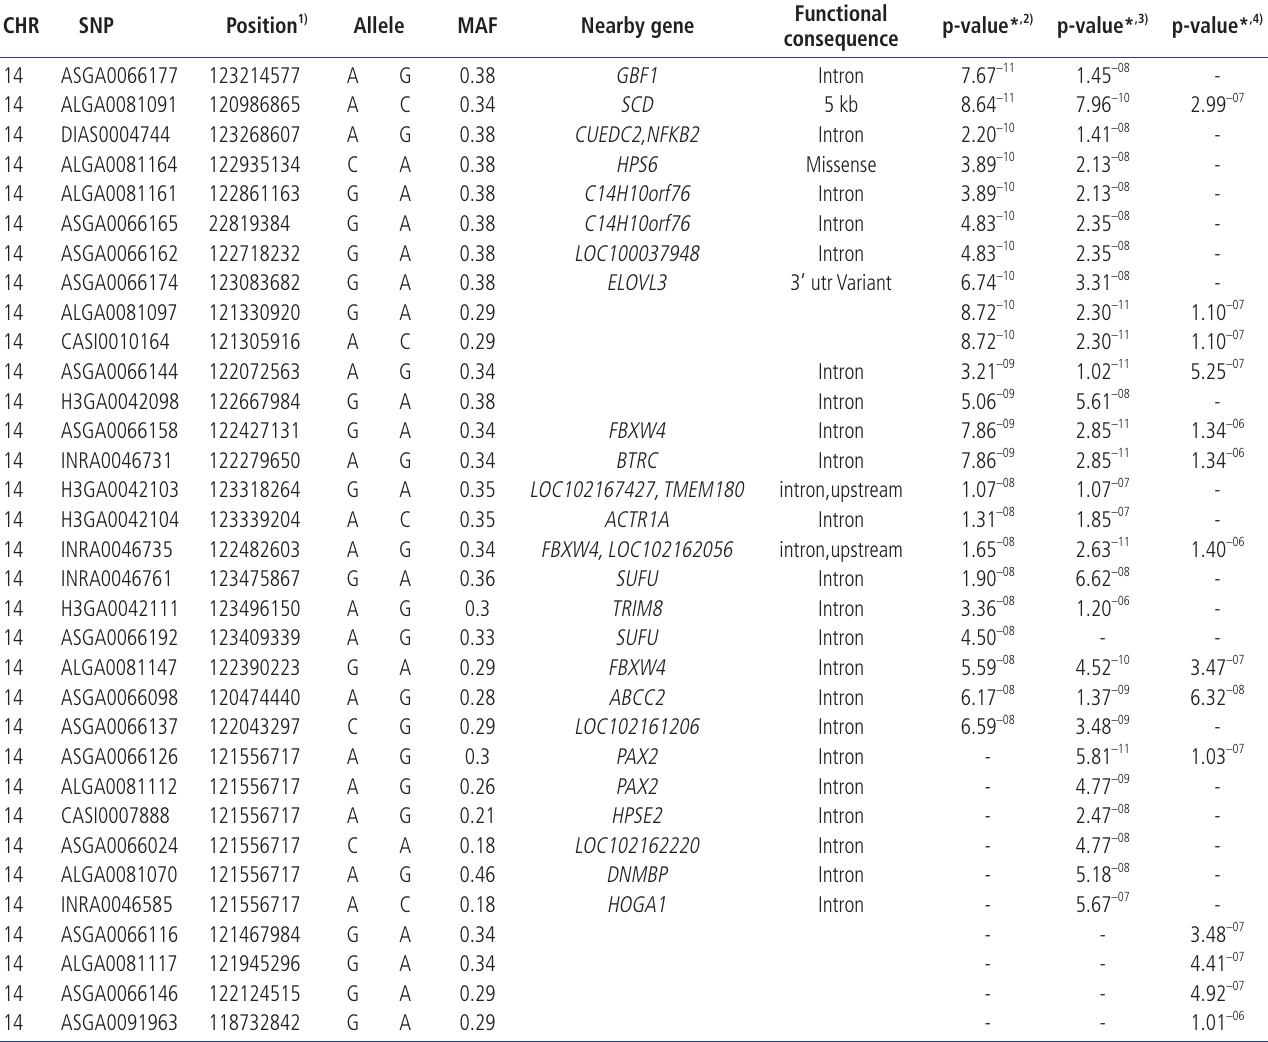
Table 2. Genome-wide significant SNP markers for oleic, stearic and SFA CHR SNP Position